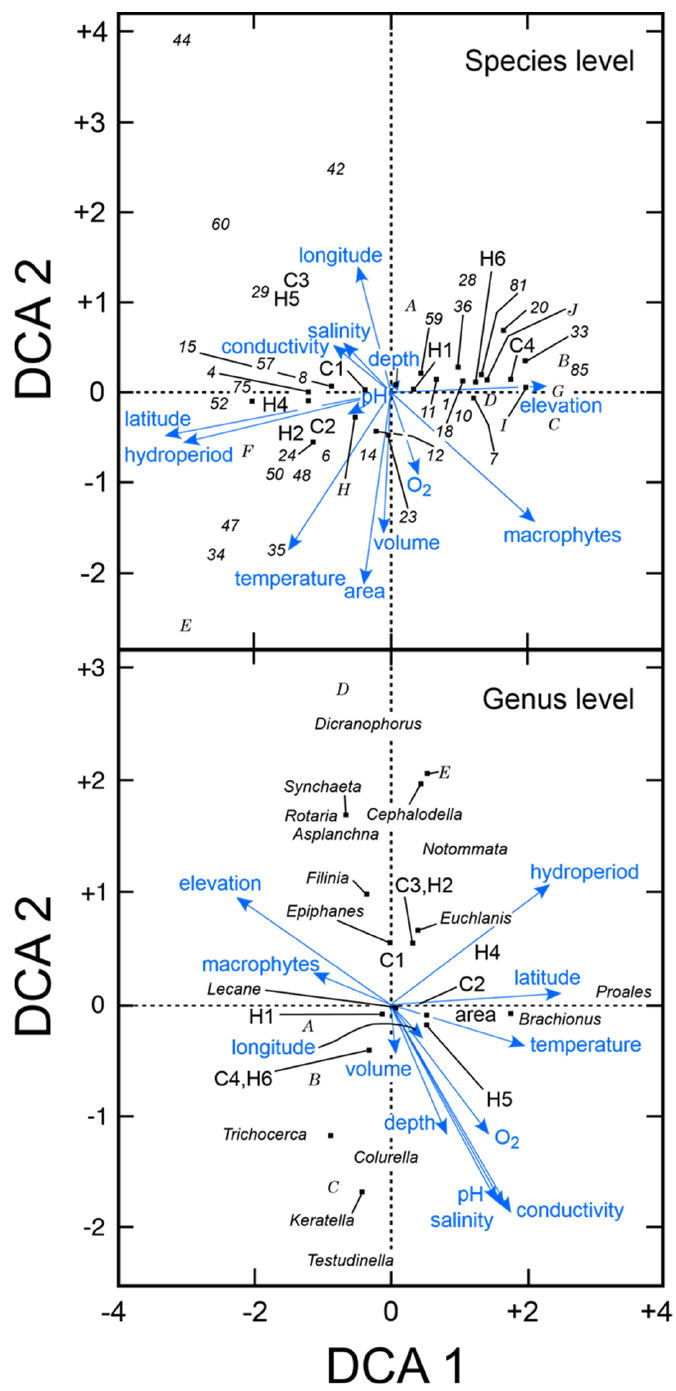
Figure 3. Unconstrained detrended correspondence analysis (DCA) of rotifers and key environmental factors for 21 Kenyan waterbodies. A. Analysis of taxa at species level. Numbers correspond to those given for species in Table 2. B. Analysis of taxa reduced to genus level. Numbers correspond to habitat types (H1 − 6) and climatic regions (C1 − 4) given in Table 1. Letters A − I include multiple species that overlapped. Upper panel: A = 32, 40; B = 19, 21, 38, 39, 49, 53, 54, 61–63, 65, 68, 69, 79, 83; C = 5, 66; D = 46, 55; E = 27, 30, 31, 45, 67, 72; F = 25, 26, 73, G = 17, 22, 58, 76, 82; H = 3, 13, 51; I = 11, 18; J = 46, 55. Lower panel: A = Nolthoca , Floscularia , Limnias , Plationus ; B = Platyias , Mytilina ; C = Polyarthra , Hexarthra ; D = Encentrum , Kostea ; E = Pleurotrocha , Dipleuchlanis